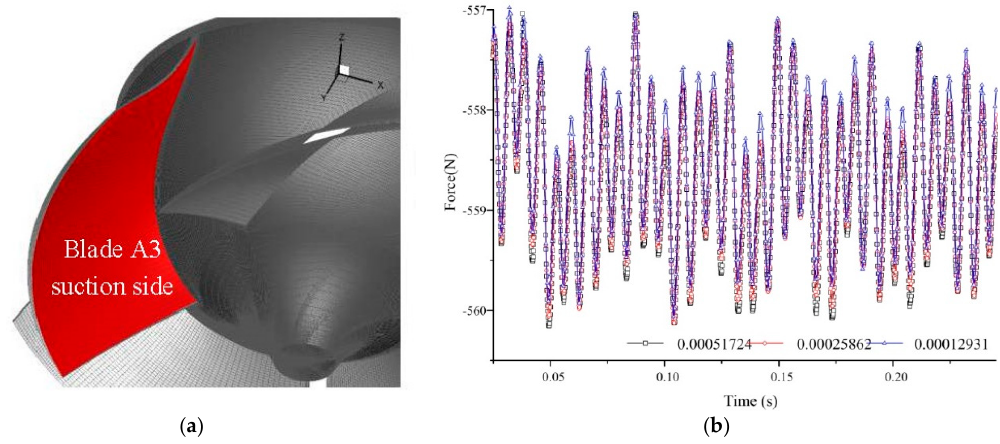
Figure 5. Time step independence test: ( a ) Blade A3 Suction Side and ( b ) Time step independence test.